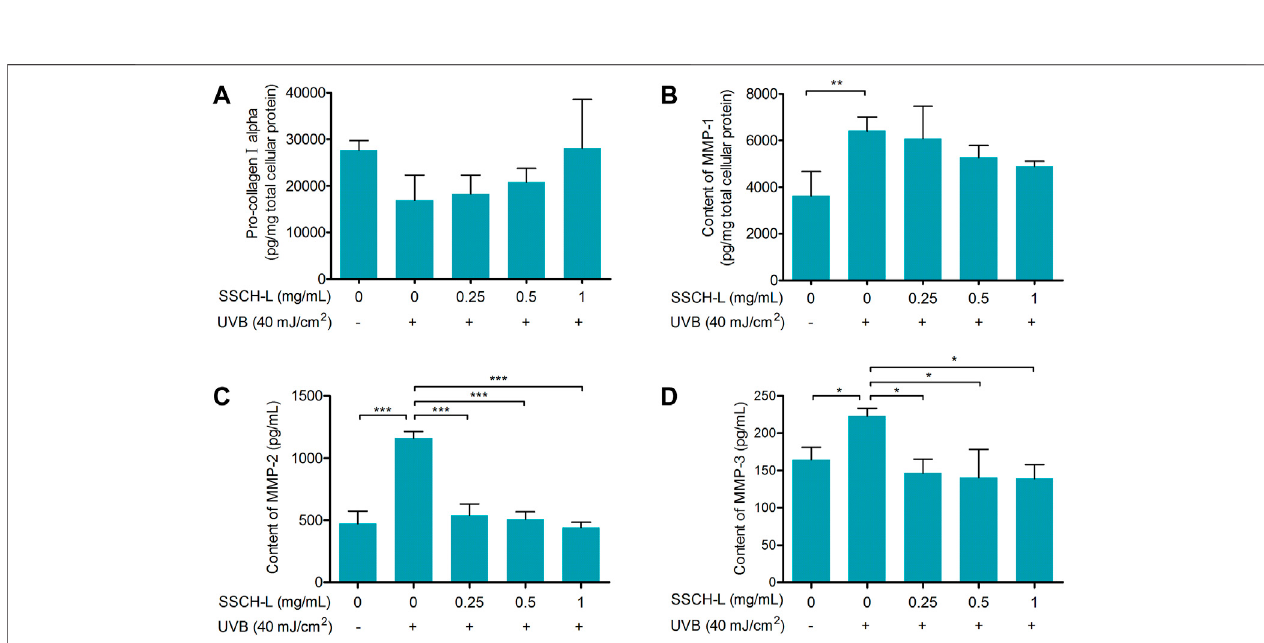
FIGURE7| TheprotectiveeffectofSSCH-LonprocollagendegradationinUVBexposedL929.TheproteinlevelsofprocollagenIalpha (A) andMMP-1 (B) inL929 cells and the levels of MMP-2 (C) and MMP-3 (D) in cell culture supernatant were detected by ELISA.